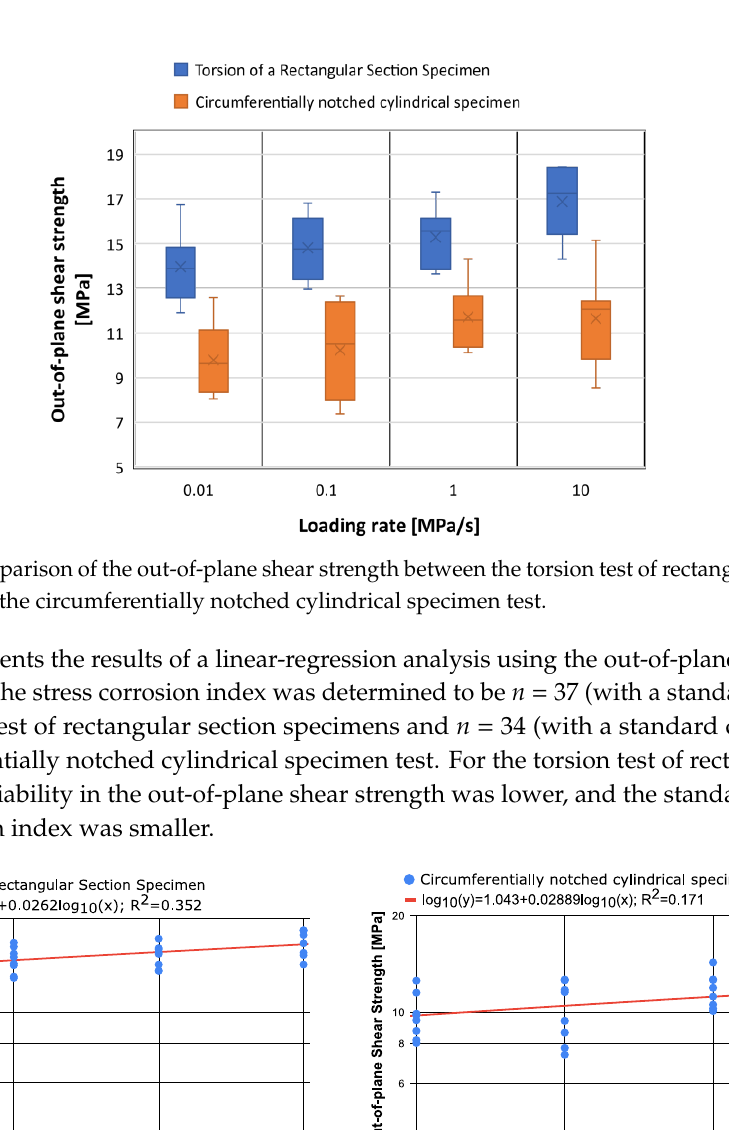
Figure 14. Out-of-plane shear strength versus loading rate: ( a ) torsion test of rectangular section specimens; ( b ) circumferentially notched cylindrical specimen test.